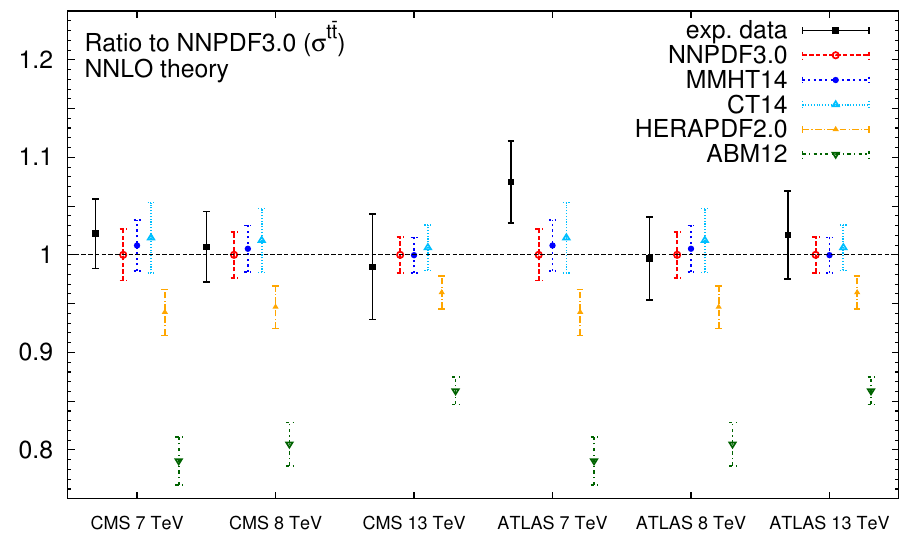
Figure 13 . The inclusive cross-sections in top-quark pair production from ATLAS and CMS p at di(cid:11)erent center-of-mass energies s (see table 2), compared to NNLO theory computed with the program top++ for the (cid:12)ve PDF sets. Results are shown as ratios to the central NNPDF3.0